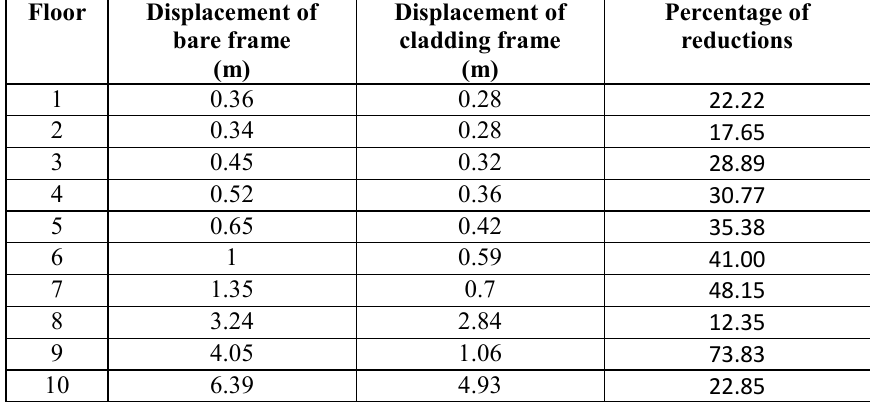
Table 5 Percentage of reduction of velocity of 10 storey structure by using cladding material.